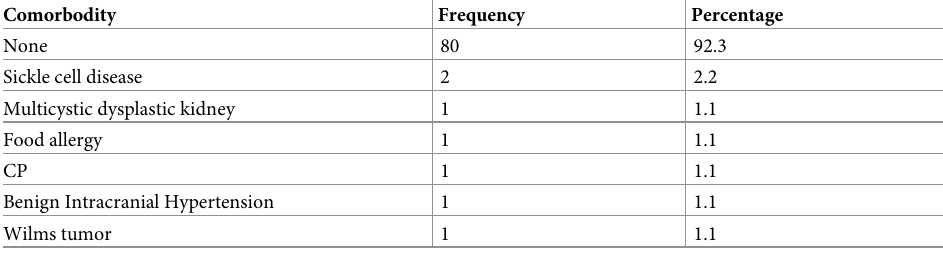
Table 5. Associated comorbidities in the study participants with